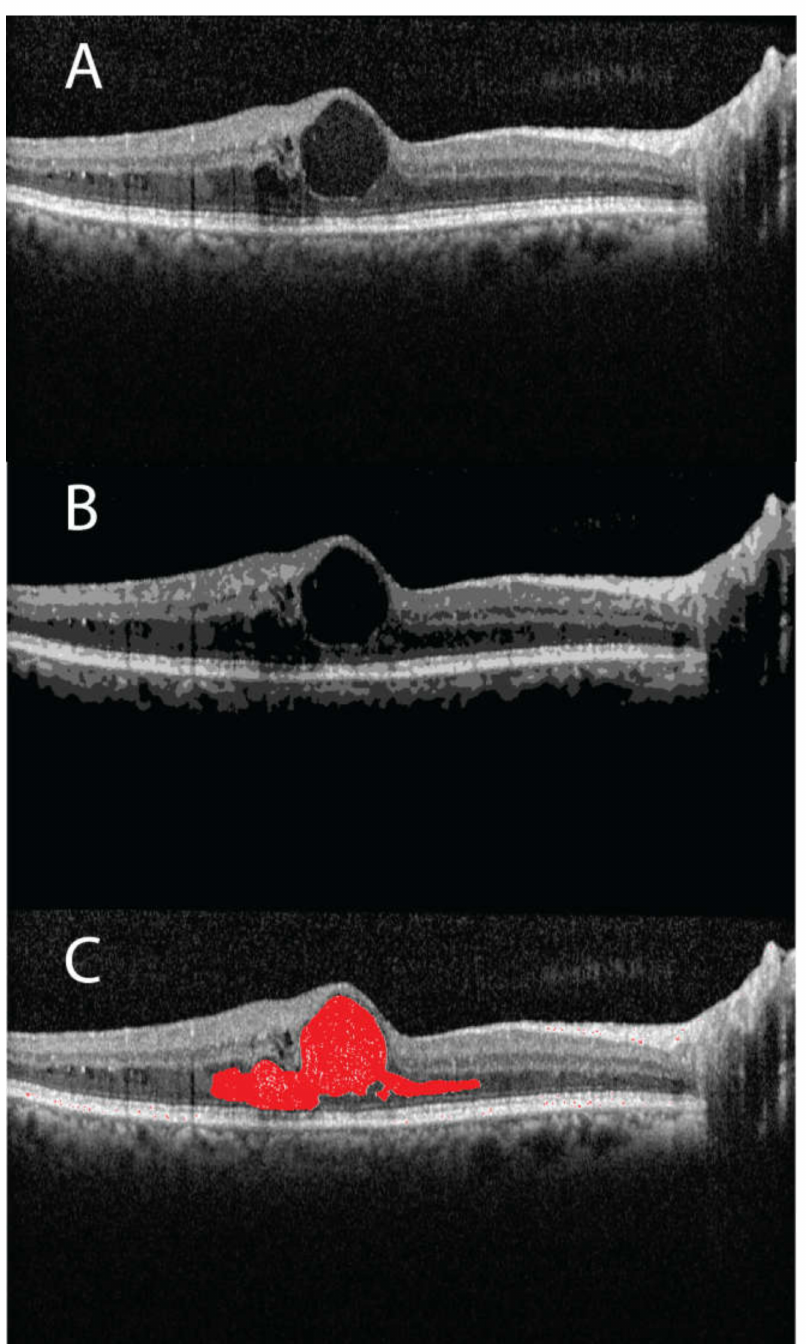
Figure 4. ( A ) A sample B-scan of a patient (categorized as recurrent and with an ETDRS grading as PDR) showing fluid filled regions; ( B ) the same B-scan is shown after signal to noise ratio balancing; ( C ) segmented fluid region is highlighted in